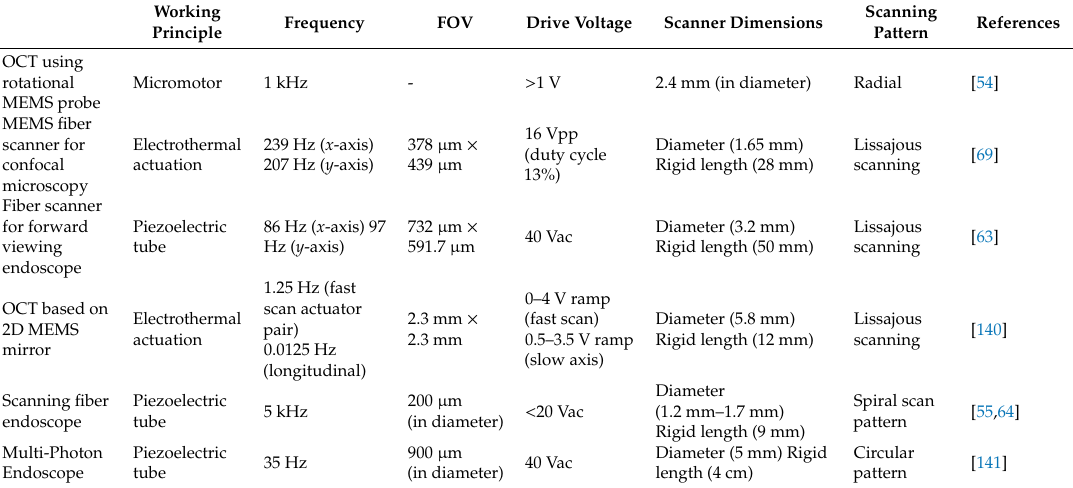
Table 6. Comparison of some advanced optical scanning